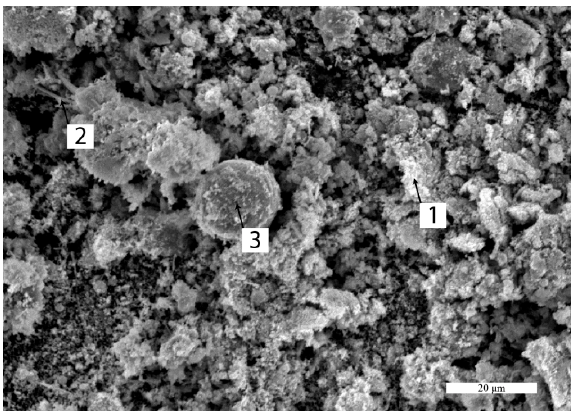
Figure 8. SEM analysis of crude ZnO dust.